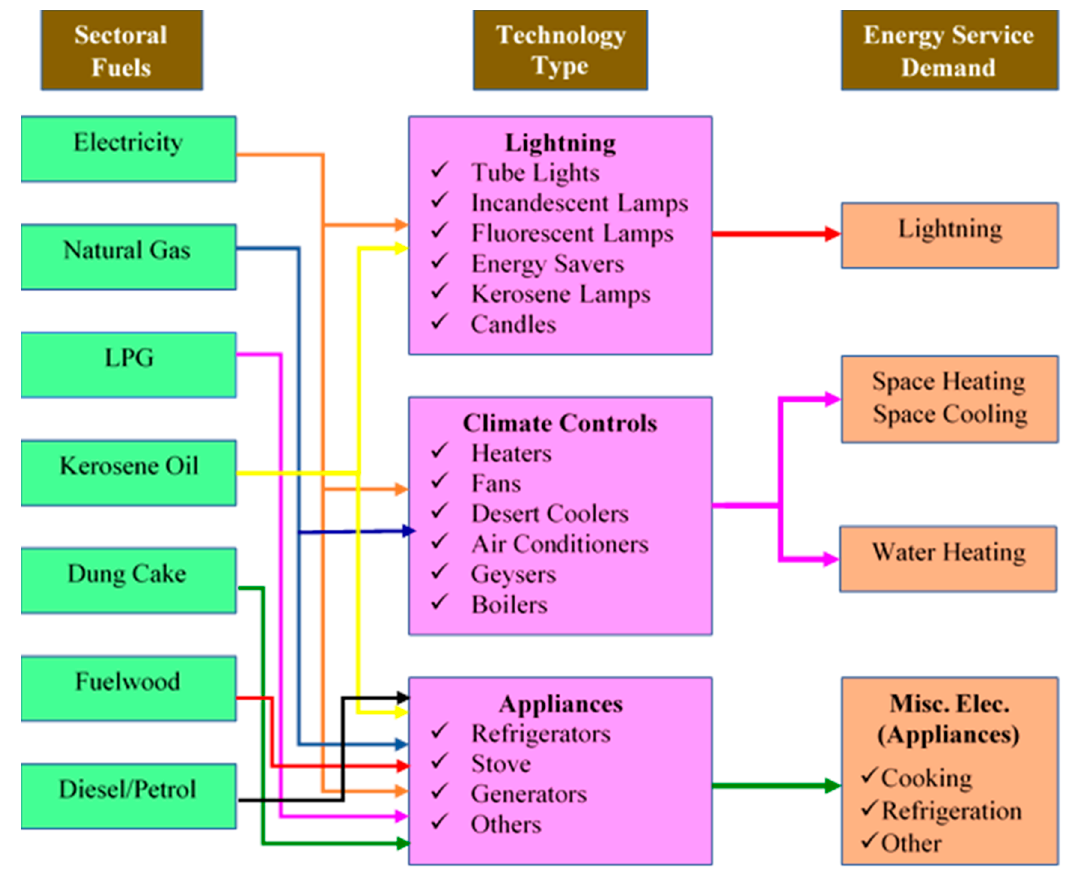
Figure 8. Energy flow across the domestic sector in Pakistan .